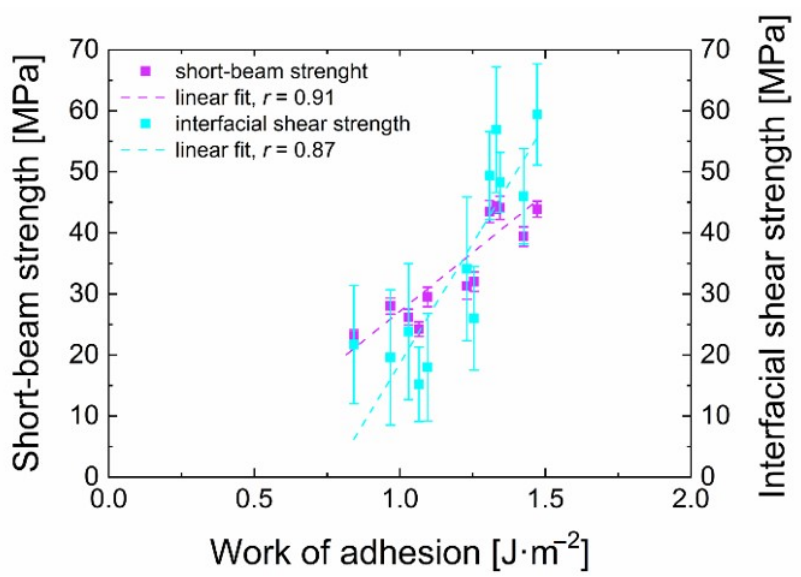
Figure 11. Relationships observed between short-beam strength/IFSS and the work of adhesion.